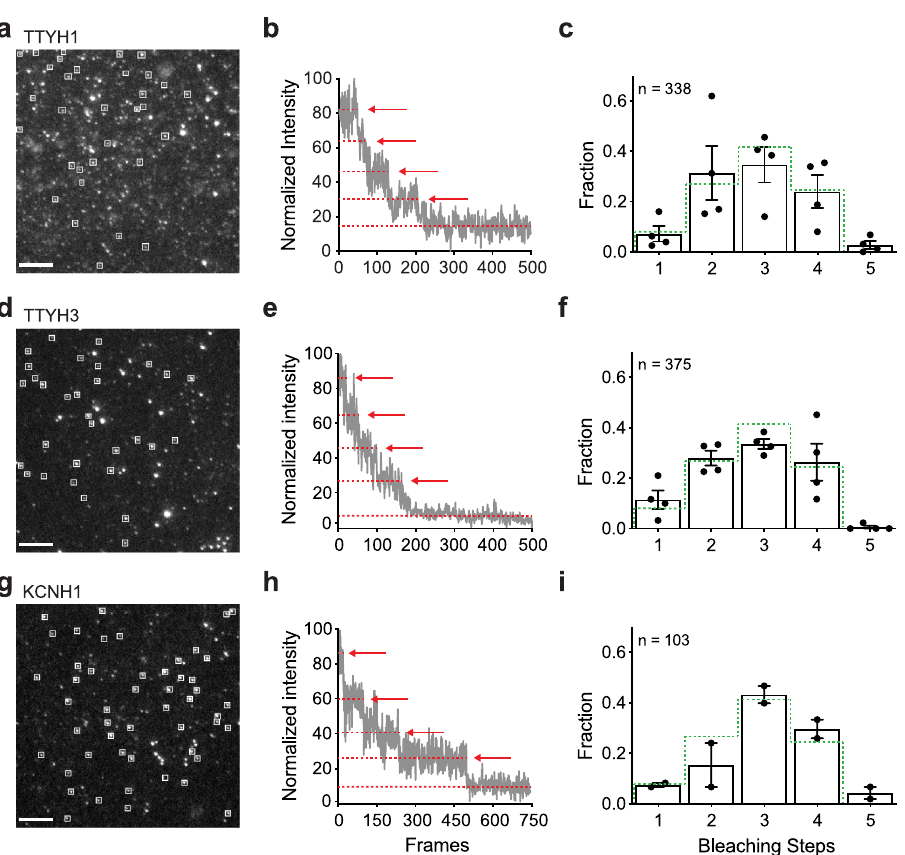
Fig. 2 Single-molecule subunit counting of mTTYH family members. Analyses of EGFP-fused mTTYH1 ( a – c ), mTTYH3 ( d – f ), and KCNH1 ( g – i ). a , d , g Representative images sampled from 2 min movies, 1-day post-injection of 1 ng cRNA, using TIRFM. Spots of interest are highlighted by white squares. Scale bar, 2 μ m. b , e , h Representative fl uorescence intensity traces obtained from single spots showing four steps of photobleaching, as indicated by arrows. c , f , i Probability distributions of bleaching steps (black bars), with error bars indicating SEM. Binomial distribution ( p = 0.7) for tetrameric complexes is presented as a dashed green line. n indicates the number of spots